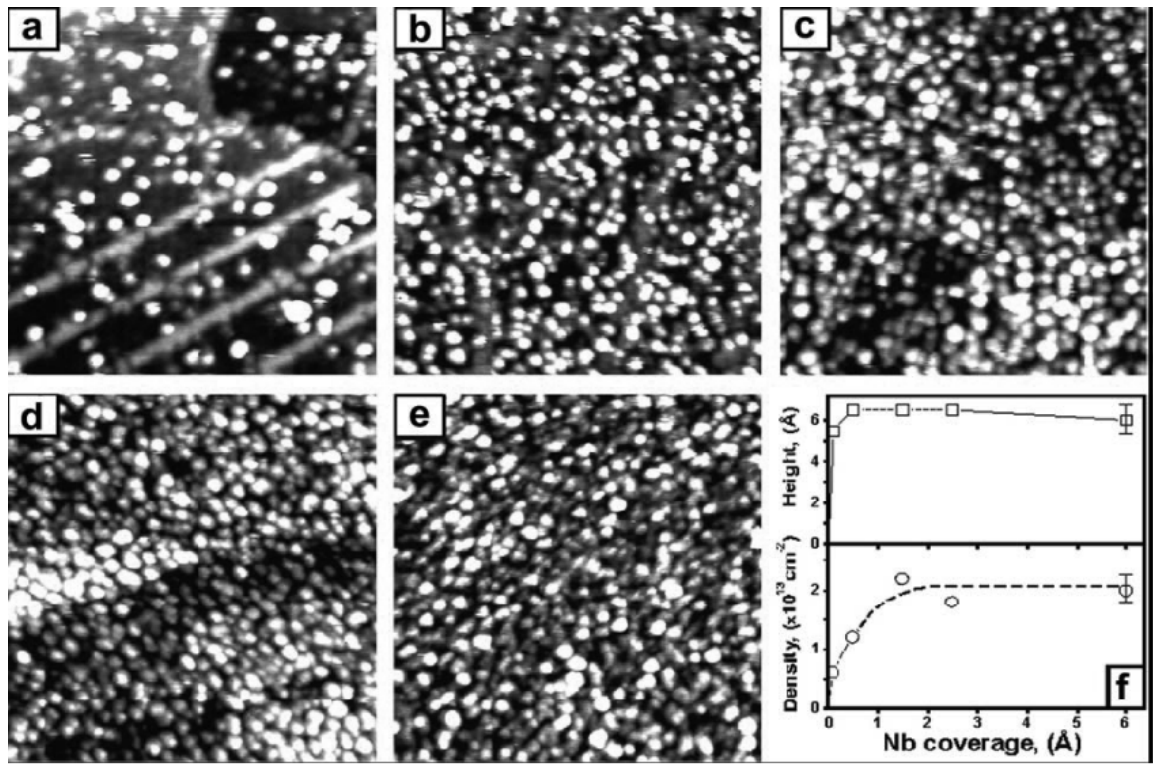
Fig. 11 – STM images (size 60 × 60 nm 2 , tunneling parameters V S = 3 V, I = 0 . 1 nA) of niobia deposited on alumina films at different coverages: (a) 0.1Å; (b) 0.5Å; (c) 1.5Å; (d) 2.5Å; (e) 6.0Å; (f) apparent height of niobia particles and particle density as a function of niobia coverage (Uhl et al.